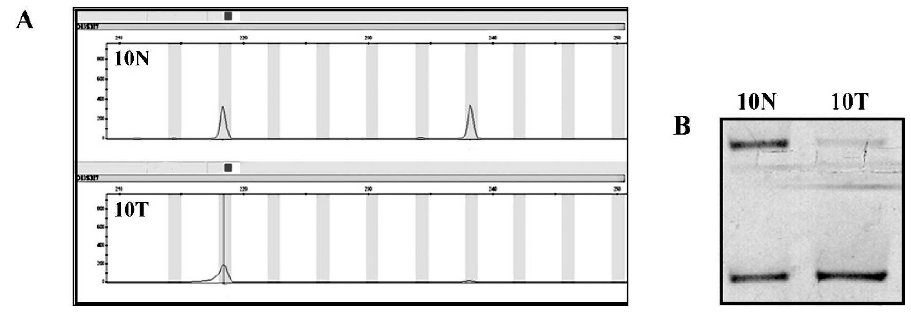
Figure 1 - Detection of LOH at the D13S317 locus. The same matched pair of samples was analyzed twice in both systems (A: Identifiler fluorescent system; and B: silver-stained polyacrylamide gel) to confirm the instability. N: normal tissue; T: tumor